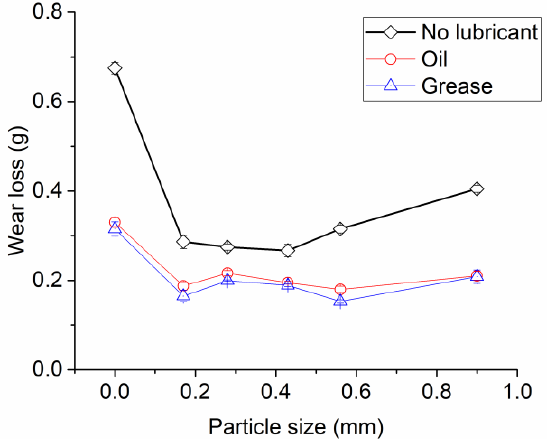
Figure 7. Average wear loss of straw powder with different particle sizes under various lubrication